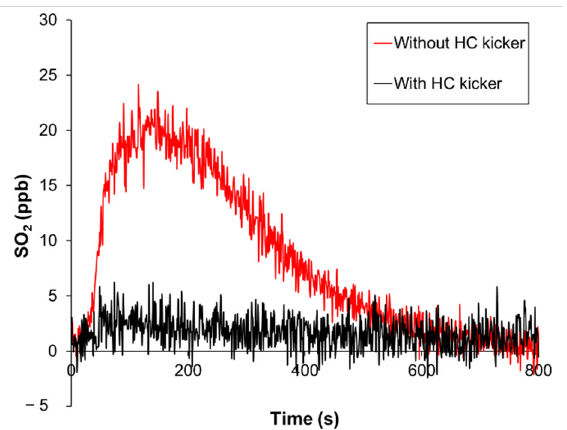
Figure 5. Erroneous SO 2 measured concentration indicates the effect VOCs (using spray paint in a lab environment) have on the SO 2 measurement signal. The red line shows the erroneous indicated SO 2 sensor reading without an HC kicker and the black line shows the erroneous sensor reading when the HC kicker was installed in the airflow before the SO 2 sensor.